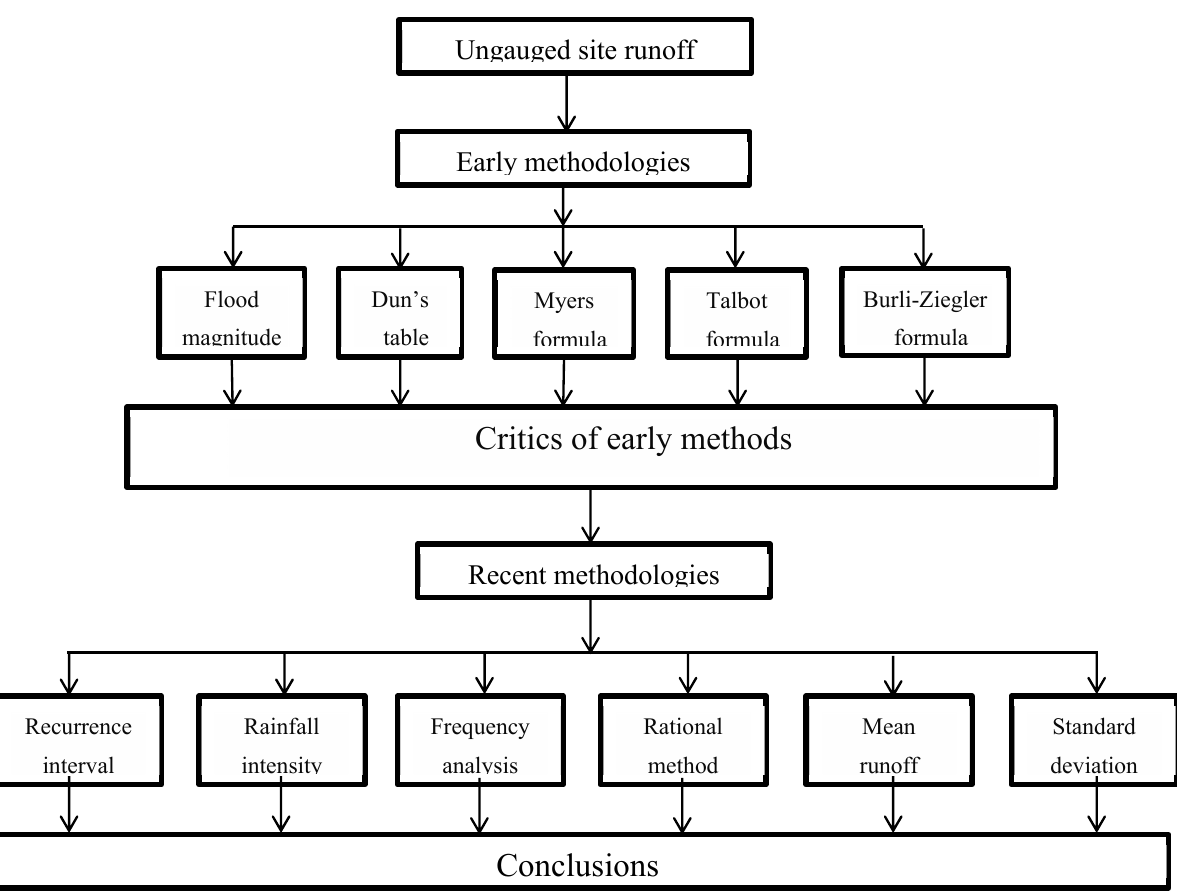
Figure 1. Content flow chart.